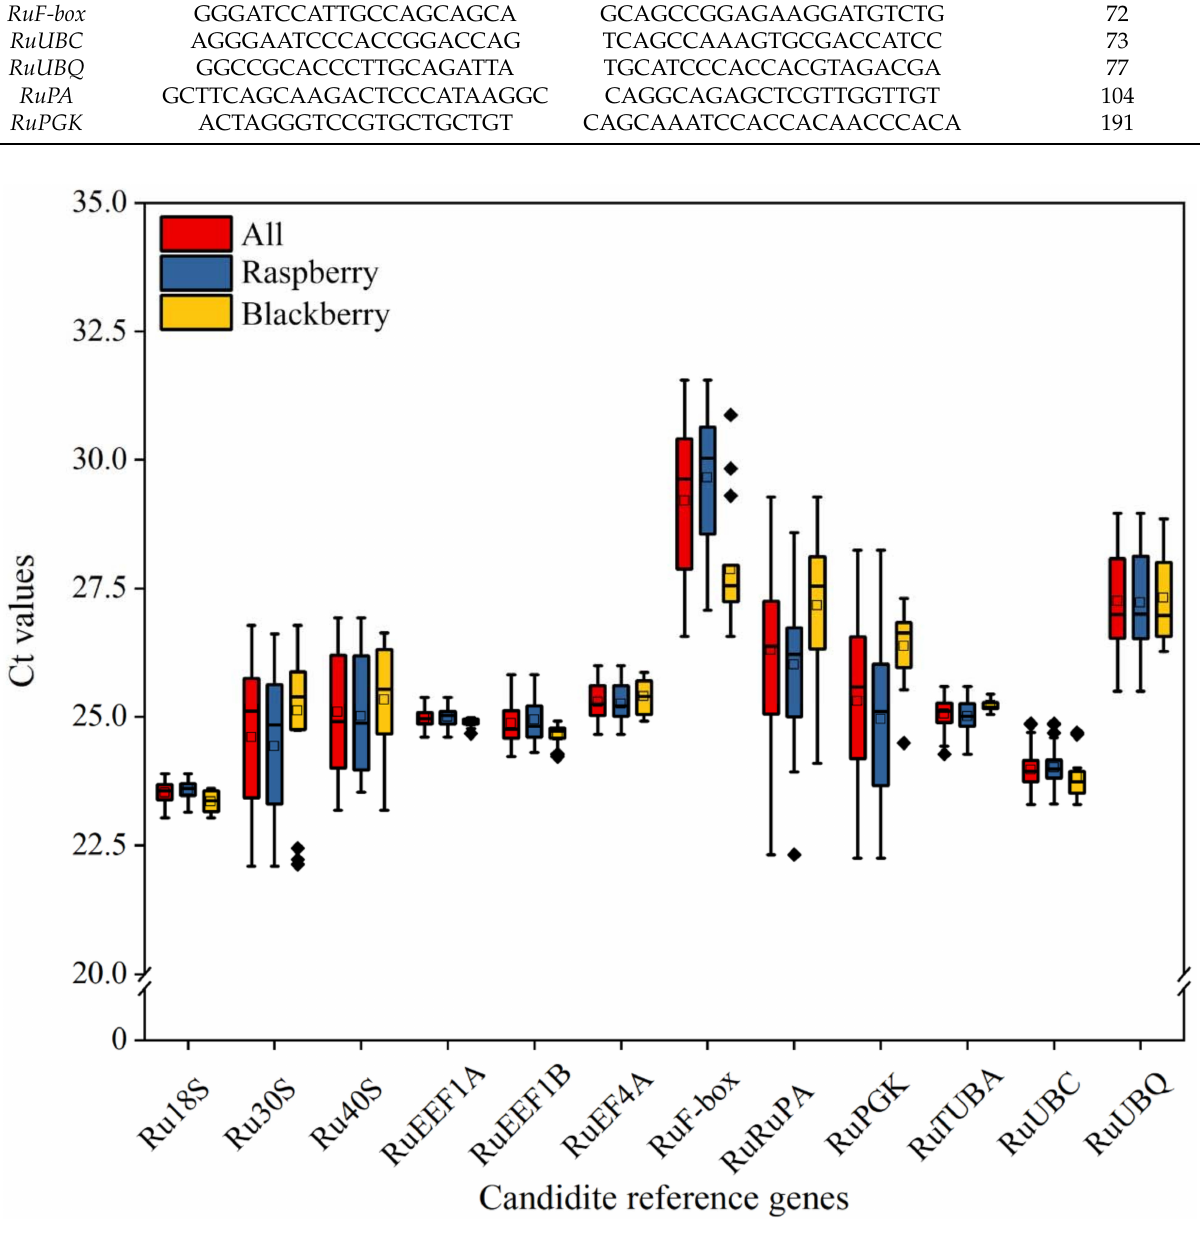
Figure 1. Cycle threshold (Ct) values of 12 candidate reference genes in all 72 samples, blackberry and raspberry. Ct distribution is presented as a box-plot, indicating the 25th and 75th percentiles. Lines across the boxes represent the median. The whisker caps indicate the maximum and minimum values. The dots represent the